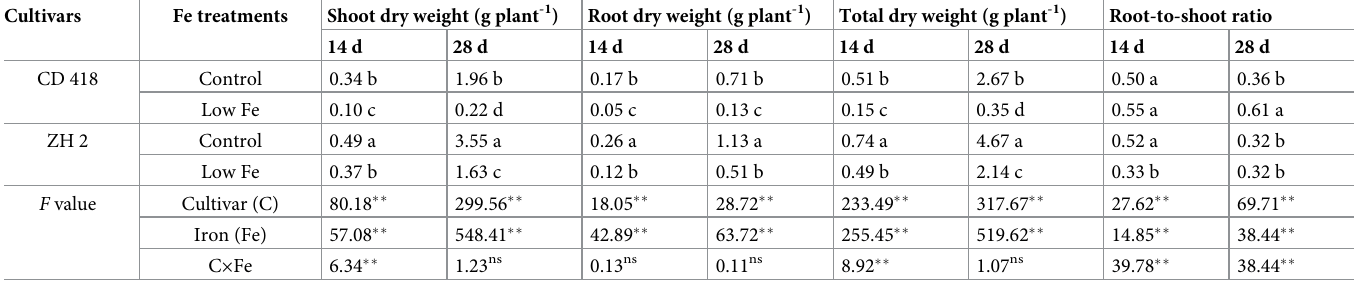
Table 1. Dry matter accumulation of maize seedlings grown under different Fe concentrations. Cultivars Fe